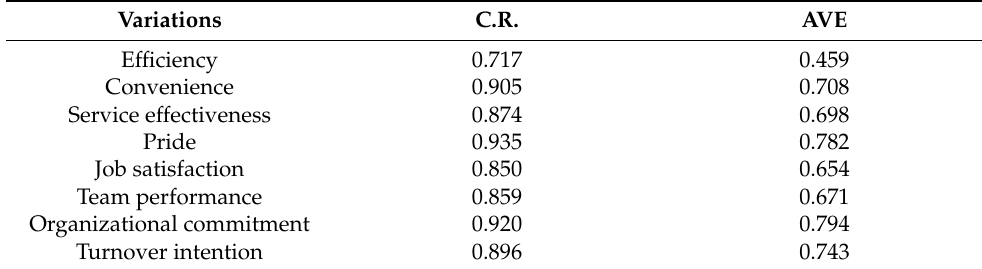
Table 3. Result of Convergent Validity.